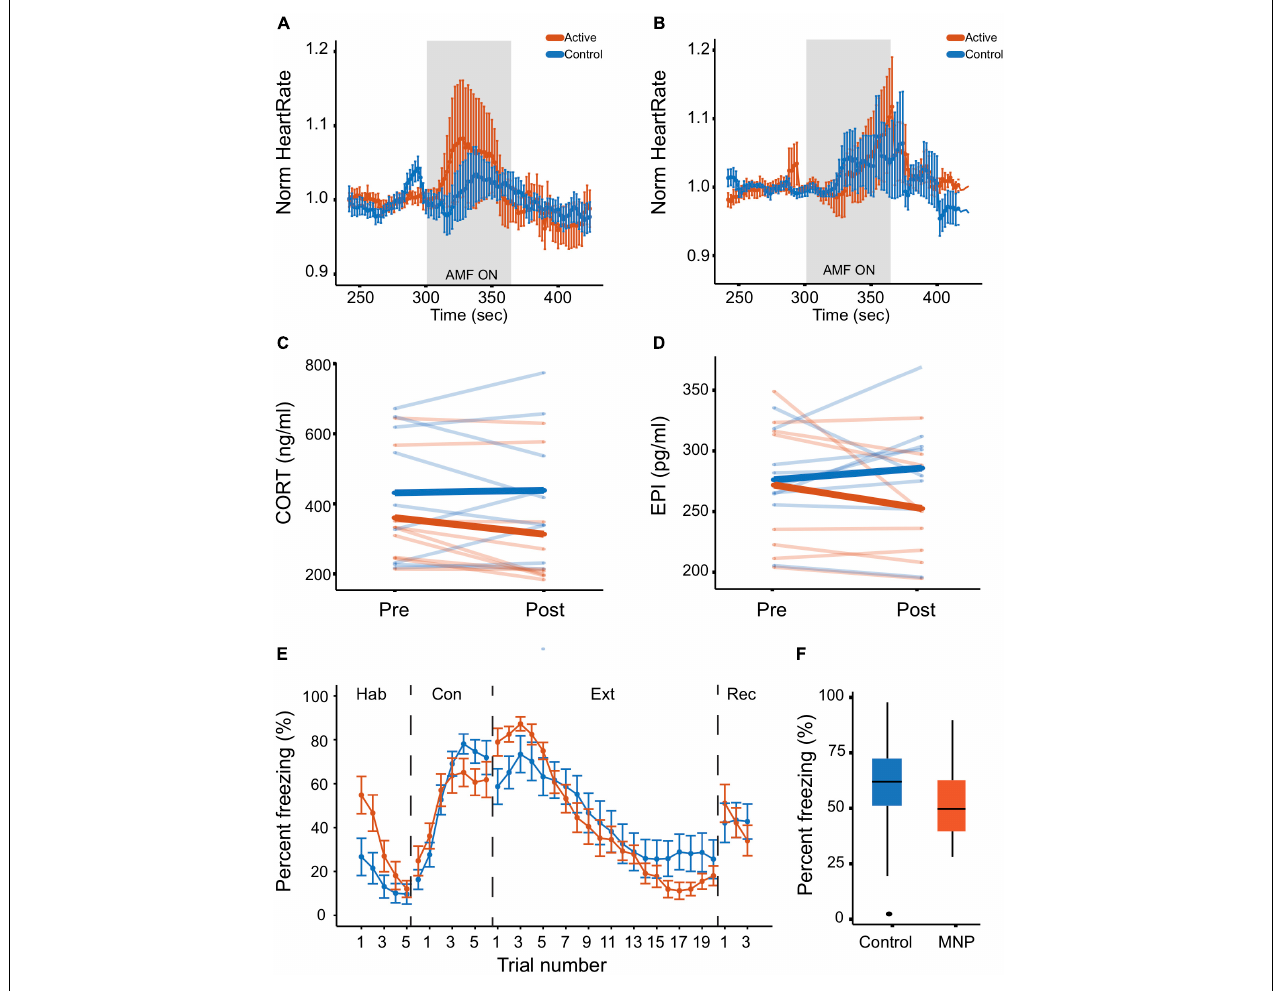
FIGURE 3 | Magnetothermal adrenal stimulation effects on heart rate and hormone levels. (A,B) Heart rate measurement during magnetothermal stimulation on (A) days 1 and 2 before conditioning and (B) on day 4 after conditioning. (C,D) Serum hormone analysis. (C) Corticosterone and (D) epinephrine were measured before (pre) and after (post) magnetothermal stimulation. (E,F) Behavioral effects of magnetothermal adrenal stimulation. (E) Percent freezing per trial across the habituation, conditioning, extinction, and recall phases of the behavioral paradigm (controls, n = 13; active, n = 10). (F) Percent freezing averaged across the last three trials of extinction (Trials 18–20) for control and active MNP